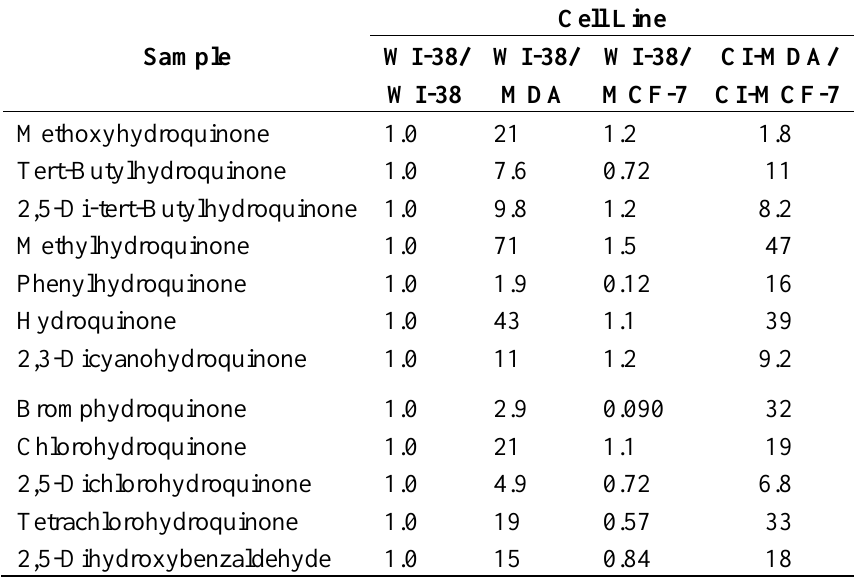
Table 4. Chemotherapeutic Index-50% for the polymers formed from reaction of dibutyltin dichloride and hydroquinone and hydroquinone derivatives for MDA and MCF-7 cell